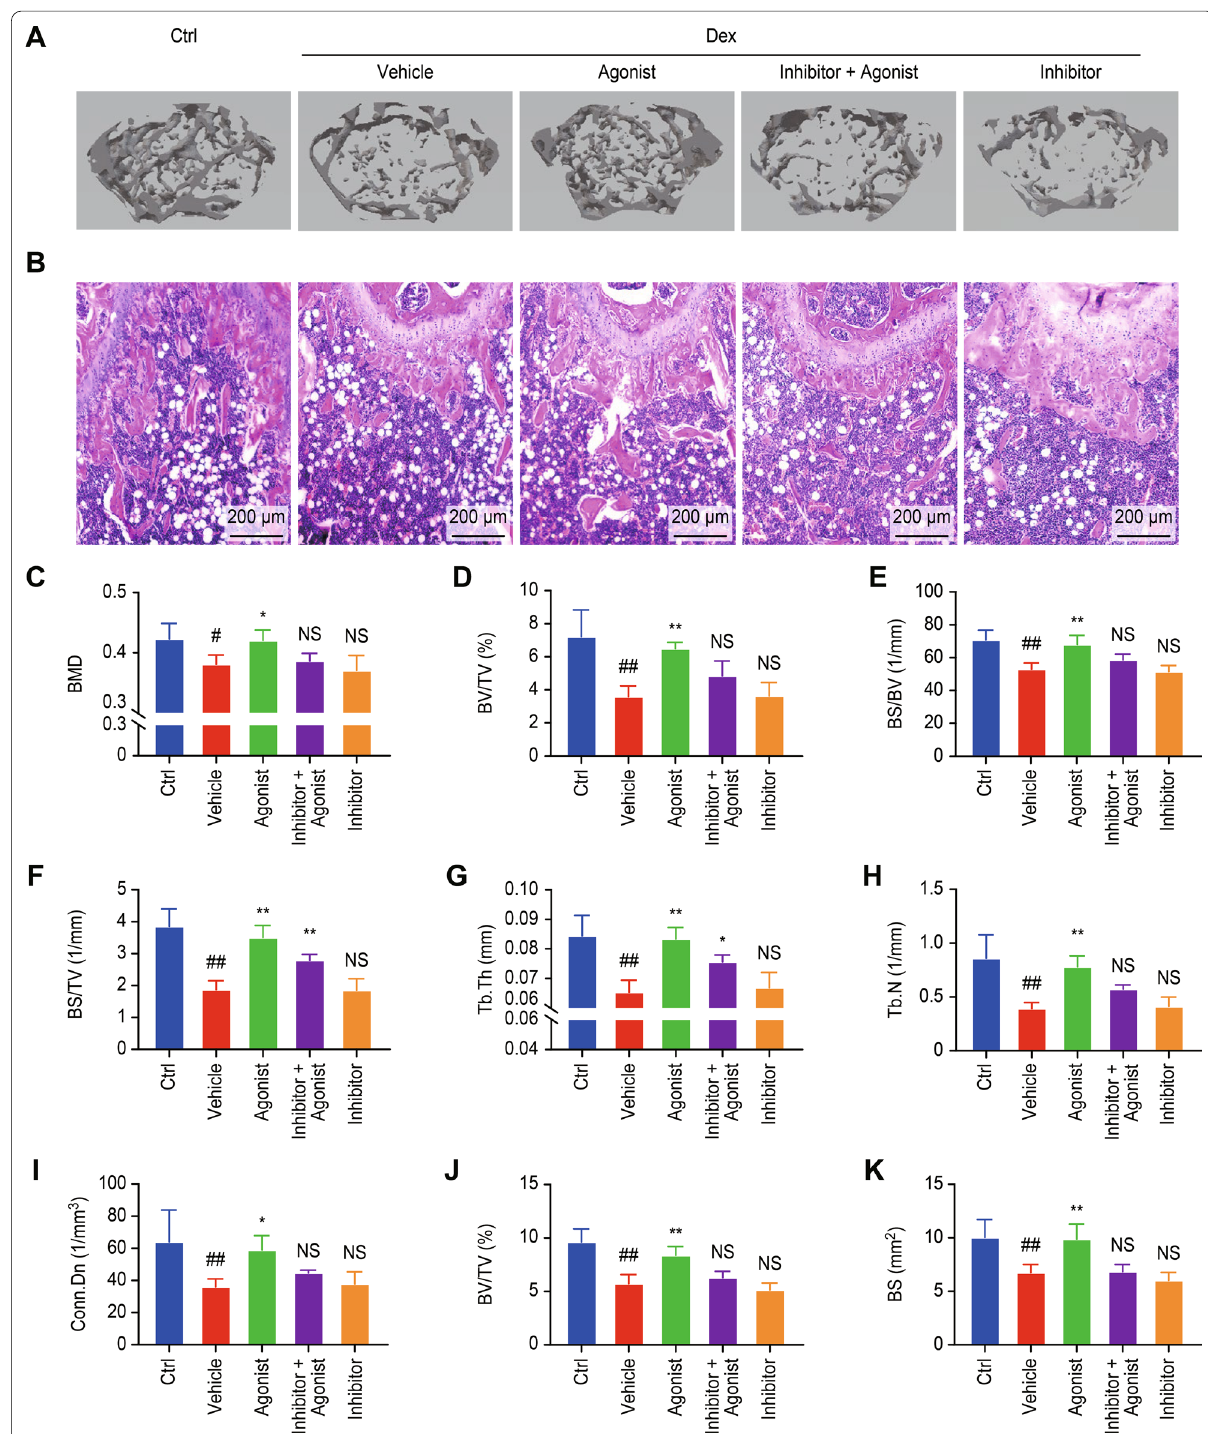
Fig. 6 Activation of D1R alleviated Dex-induced osteoporosis in vivo. A Representative 3D reconstructions of μCT images and B representative paraffinized sections stained with H&E. C BMD within the region of interest (ROI) was calculated by μCT. D BV/TV E BS/BV, F BS/TV, G Tb. Th, H Tb. N. and I Conn.Dn. J and K BV/TV and BS within the ROI were analyzed by H&E staining. n p < 0.01, vs. the vehicle group, # p < 0.05, ## p < 0.01, vs. the control